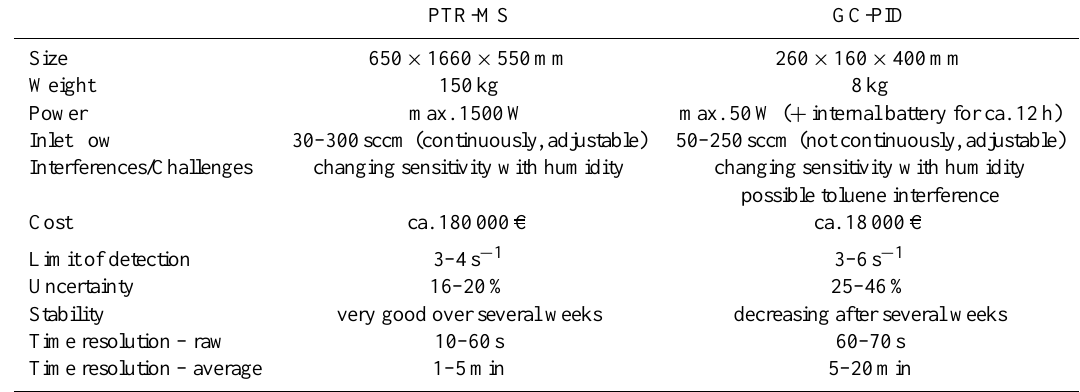
Table 2. Detailed comparison of technical, instrumental and operational parameters of PTR-MS and